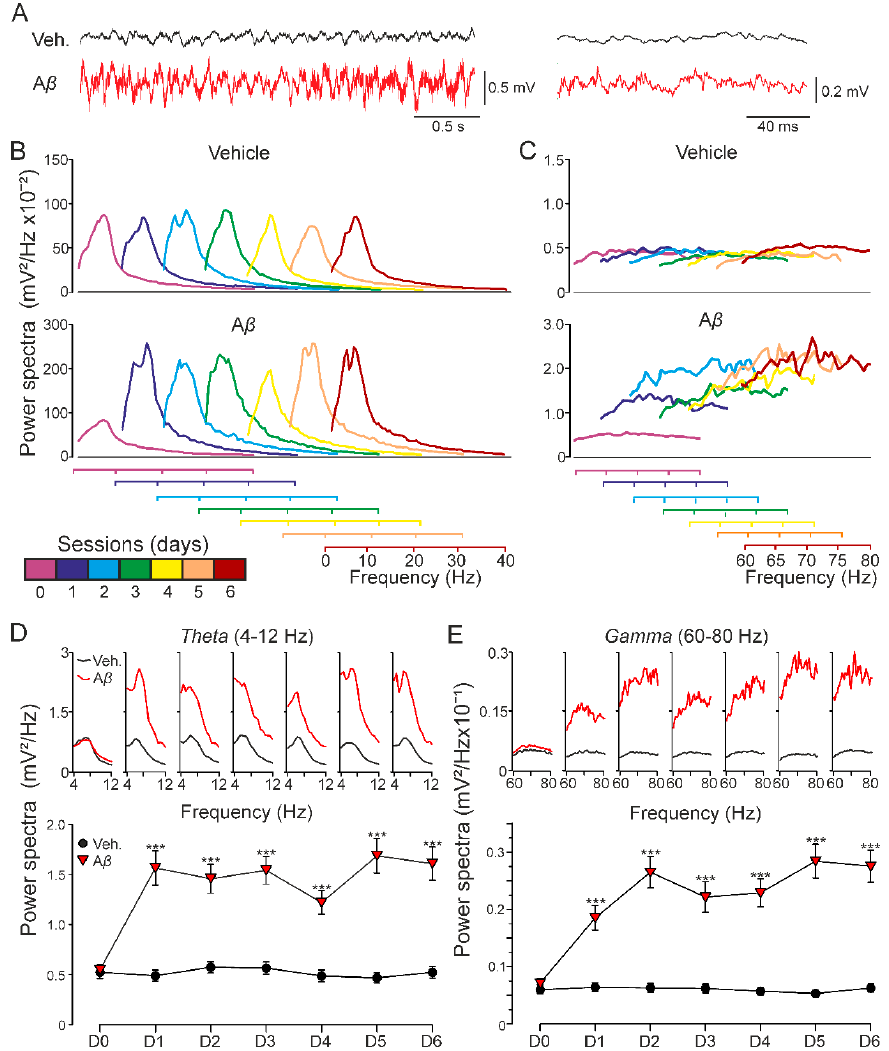
Figure 3. Oscillatory activity in CA1 region of behaving mice. Spectral power of 180 s LFP recordings at the CA1 area obtained on 6 consecutive days in the absence of any electrical stimulation for two experimental groups: vehicle and A β 25-35 . ( A ) Representative example of LFP recorded from CA1 hippocampal region in behaving mice. Note the different time scales for the traces illustrated on the left and right. ( B ) Low-frequency and ( C ) high-frequency bands were analyzed. Recordings on day 0 were collected previous to icv. administration (purple). Injections were performed on days 1, 2, and 3, recording 1 h after each one. LFP evolution was also followed 24, 48, and 72 h post icv. (days 4–6). Additionally, each day (D0-D6) spectral power of frequency intervals corresponding to hippocampal theta (( D ); 4–12 Hz) and gamma (( E ); 60–80 Hz) bands is represented (on top) along with the average value for that interval (below; mean ± SEM). After icv. administration, A β -injected mice showed increased spectral power at both low and high frequencies compared to vehicle-injected animals, and the same result was found for theta and gamma rhythms. *** p < 0.001.